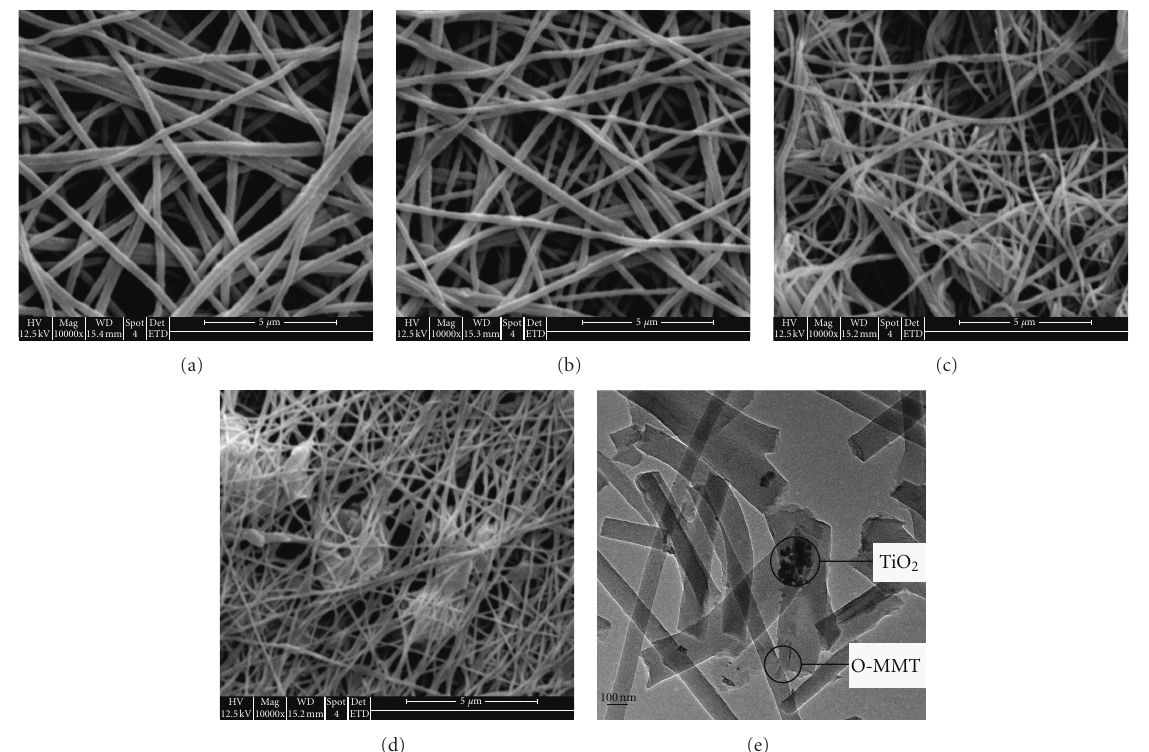
Figure 3: SEM (a–d) and TEM (e) images of PAN and PAN/O-MMT spin coated with TiO 2 : (a) 0wt.% O-MMT; (b) 1 wt.% O-MMT; (c) 3wt.% O-MMT; (d) 5wt.% O-MMT; (e) TEM of